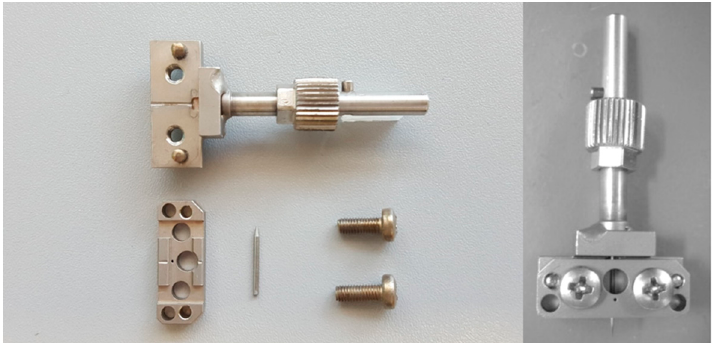
Figure 2. Indenter holder for cone indenter.